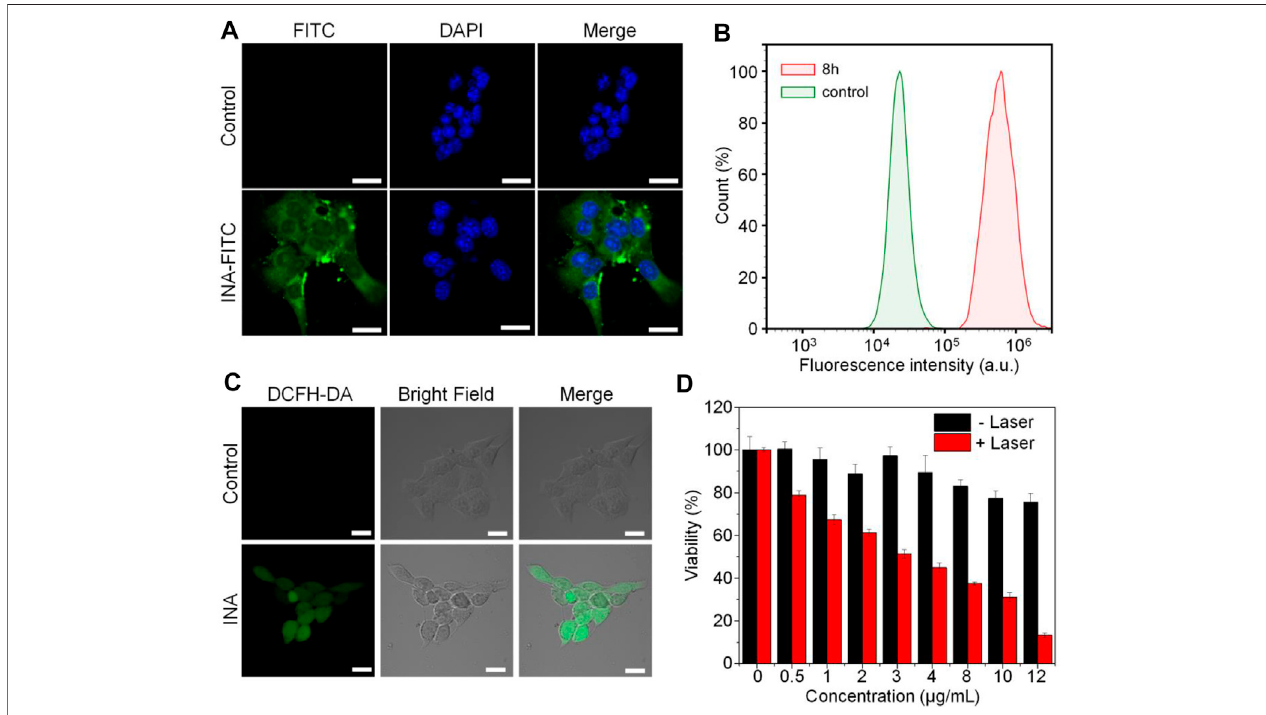
FIGURE3| Cellstudies. (A) Confocalimagesof4T1cellswithorwithoutINA-FITCincubationfor8 h.ThecellnucleiwerestainedwithDAPIwhichindicatedasblue color. (B) Quanti fi cationof fl uorescenceintensityin4T1cellsincubatedwithINA-FITCfor8 hby fl owcytometry. (C) Confocalimagesof4T1cellsincubatedwithINAand DCFH-DAunder635-nmlaserirradiationfor12 min (D) Cellviabilityof4T1cellsafterincubatingwithINAfor24 hatdifferentconcentrationswithorwithout635-nmlaser irradiation (1 W cm − 2 ). The scale bars represent 20 μ m. The error bars represent the standard deviation of three separate measurements.